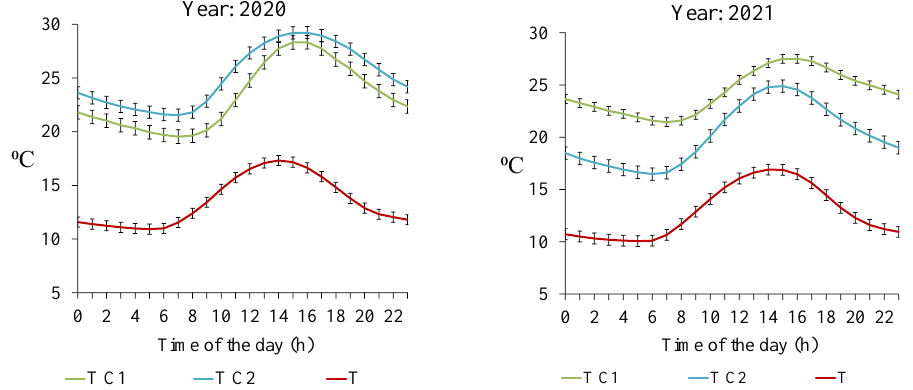
Figure 4. Mean and standard deviation values of the hourly external temperature (T) and internal temperature of the two colonies (T C1 and T C2) in the two years of study (2020 and 2021).